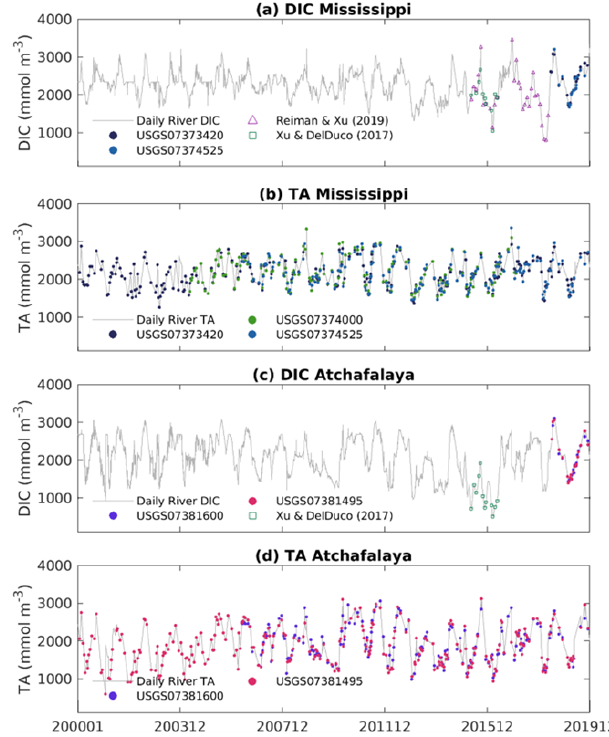
Figure 3. River DIC and TA concentration prescribed in the model. Grey lines are the interpolated daily concentration values; colored data points are raw data collected from multiple